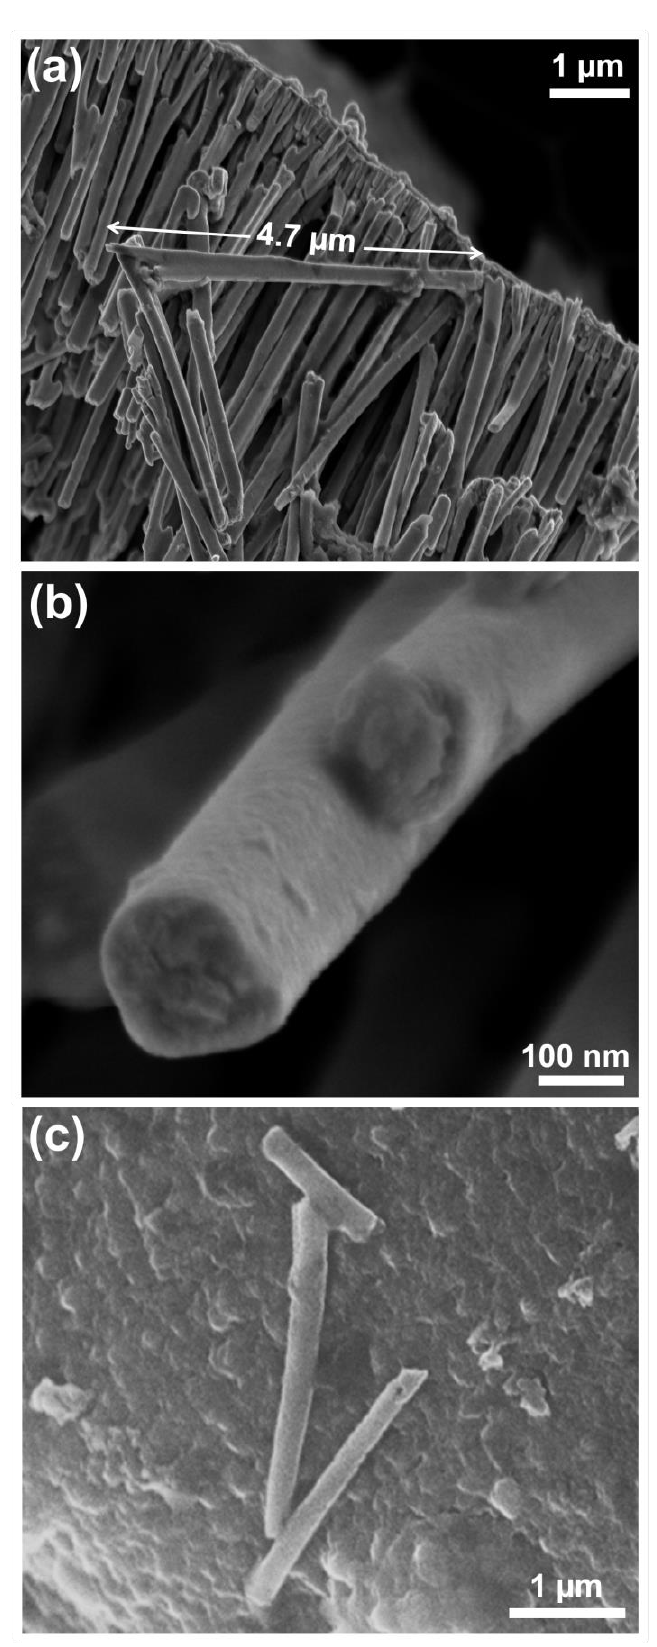
Figure 1. FESEM images of FePd NWs obtained by electrodeposition at E on = – 1.2 V on AAO membranes of ( a , b ) 20 nm and ( c ) 100 nm in diameter.